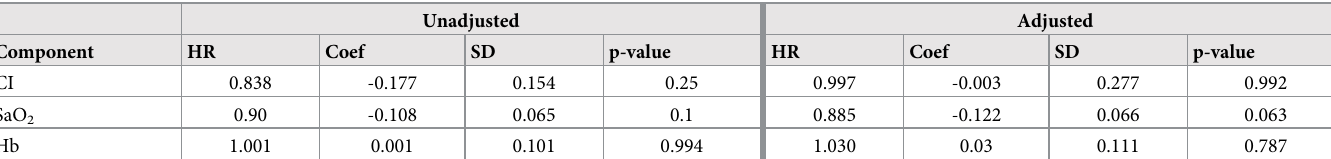
Unadjusted Adjusted